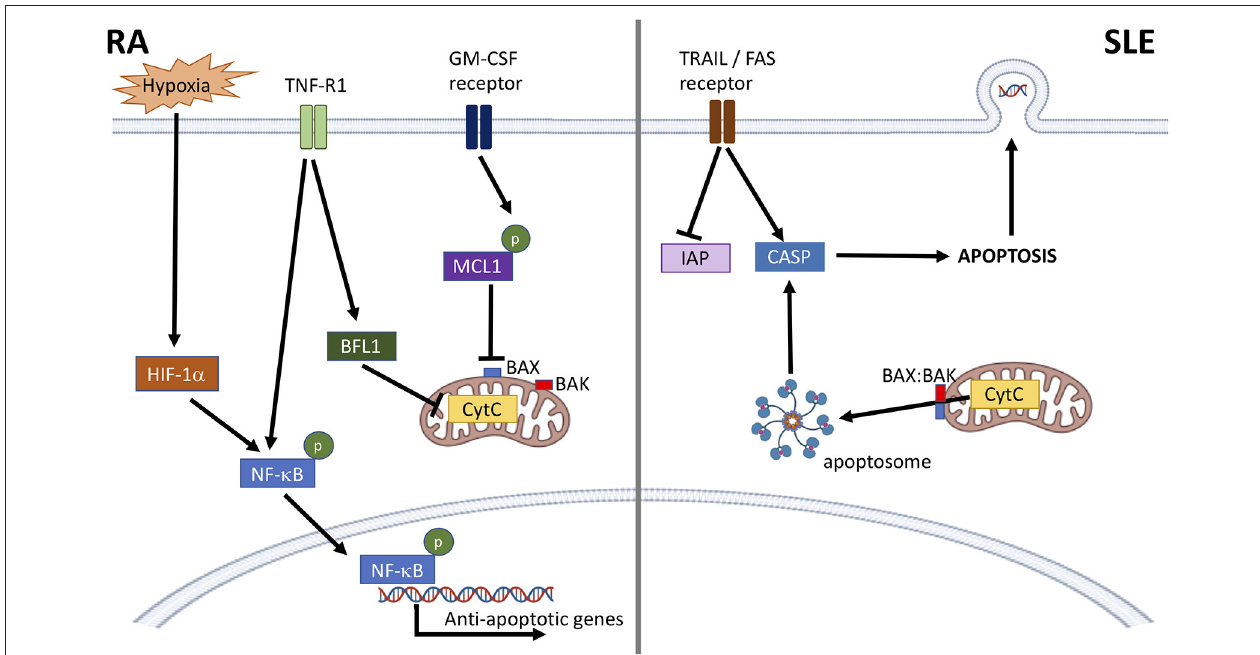
FIGURE 1 | Dysregulation of neutrophil apoptosis in RA and SLE. In RA, anti-apoptotic factors, such as cytokines and hypoxia activate NF- κ B and prevent mitochondrial cytochrome c (CytC) driven apoptosis through activation of BFL1, and stabilization of MCL1. This prevents BAX:BAK pore formation, CytC leakage and formation of the apoptosome. In SLE, activation of death receptors (e.g., TRAIL, FAS receptors) lowers levels of cellular inhibitors of apoptosis (IAP) and activates caspase-8 (CASP). BAX:BAK pore formation in the mitochondrial membrane releases CytC leading to apoptosome formation and activation of CASP-9 and CASP-3 leading to apoptosis. Nuclear antigens, including DNA, are also expressed at the plasma